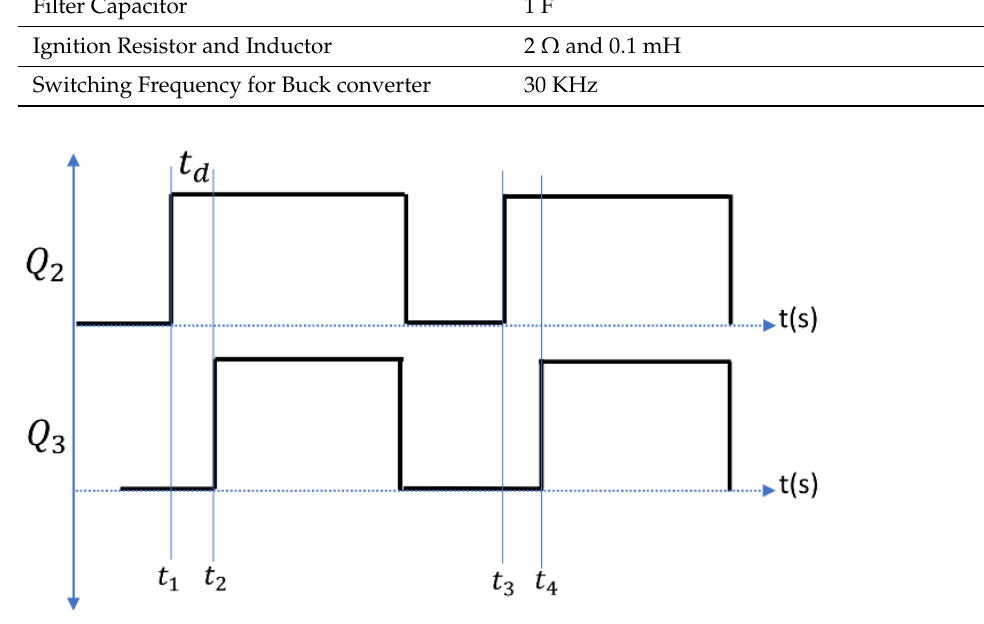
Figure 7. Q 2 and Q 3 MOSFETS ON/OFF condition.